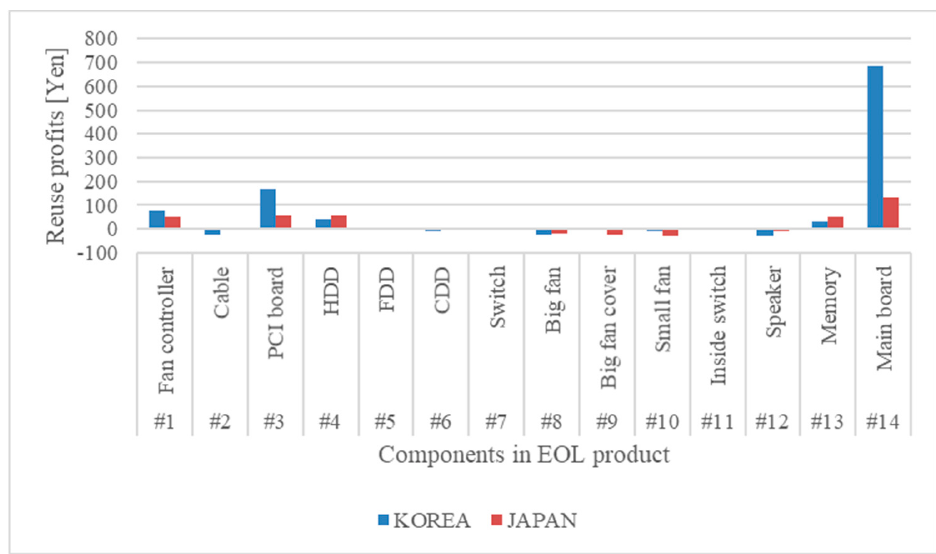
Figure 5. Comparison of reselling profits for each component in Korea and Japan.